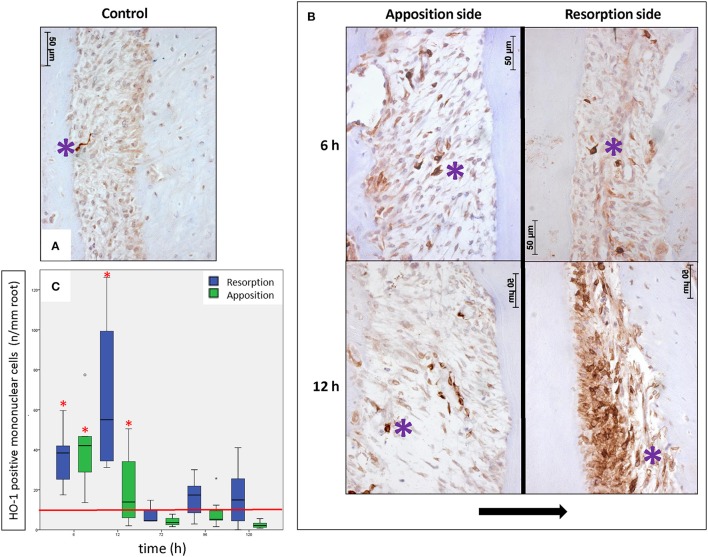
Effects of orthodontic force on HO-1 expression in the PDL (HO-1 immunostaining, magnification: x400, purple asterisk indicates a HO-1 overexpressing cell, black arrow indicates the direction of the tooth movement). (A) Only few strong HO-1 positive cells are observed in PDL tissue in control sections (control group 6 h). (B) Many HO-1 overexpressing cells were present in PDL tissue at both the apposition- and resorption side in experimental sections of experimental time 6 and 12 h. This was especially evident in the vicinity of blood vessels. (C) Box-plot of monunuclear PDL cells at the experimental sides compared to control. The number of HO-1 positive mononuclear PDL cells is significantly higher at 6 and 12 h of force application compared to the control group (base-line HO-1 expression in PDL, red horizontal line), for both the apposition- and resorption side (Kruskal-Wallis ANOVA on ranks tests, p < 0.001). *Significantly different from base-line HO-1 expression in PDL, p < 0.05.